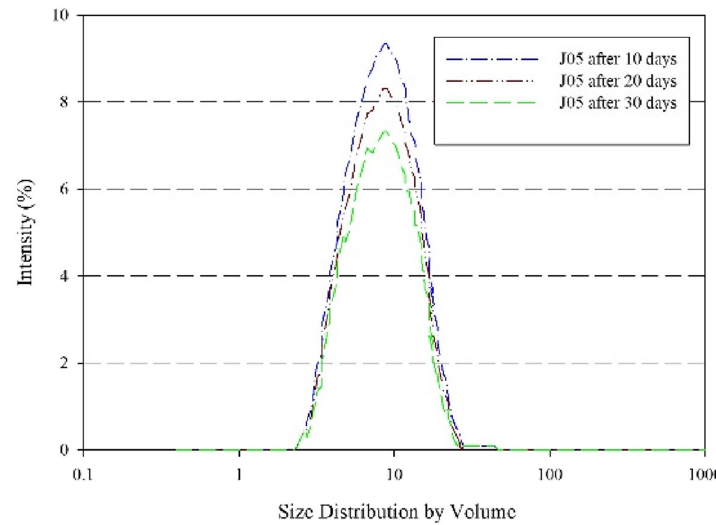
Fig. 5 DLS size distribution of J05 after 10, 20, and 30 days